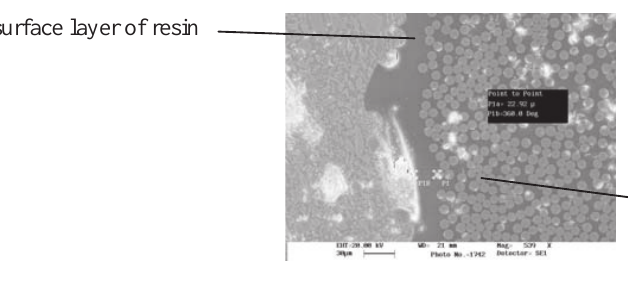
Fig. 2. Microscope image of a section of a glass fiber composite